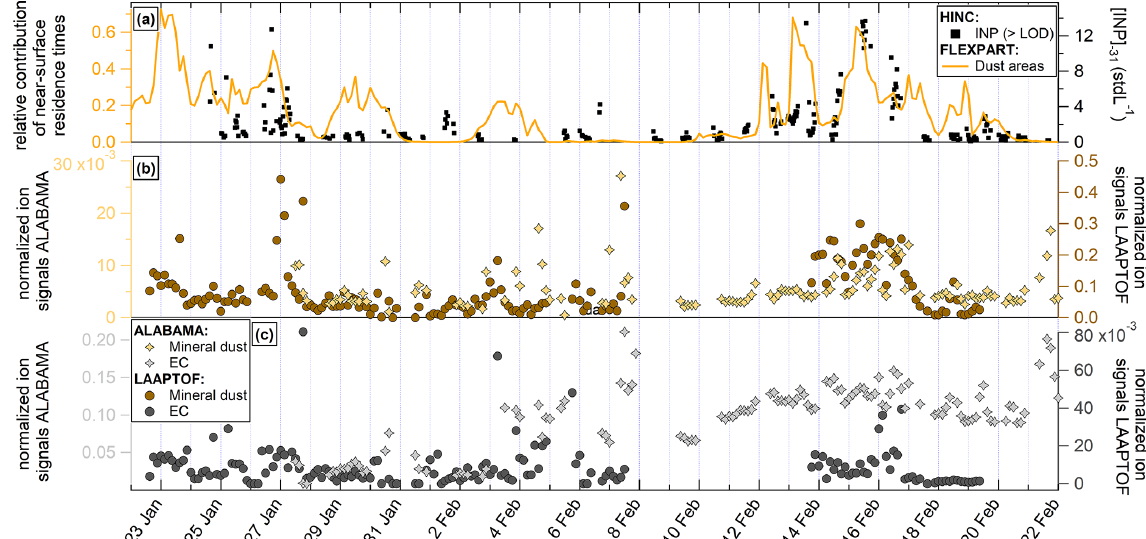
Figure 5. Time series of FLEXPART emission footprint sensitivities for desert dust surfaces (northern Africa and Middle East, Sect. 2.7) along with INP concentration (a) ; timeline of single particle mass spectrometer marker ions for mineral dust particles (b) and EC marker ions (c) for both ALABAMA and the LAAPTOF. SPMS reference spectra of the mineral dust and EC-containing particle types are shown in Figs. S10 and